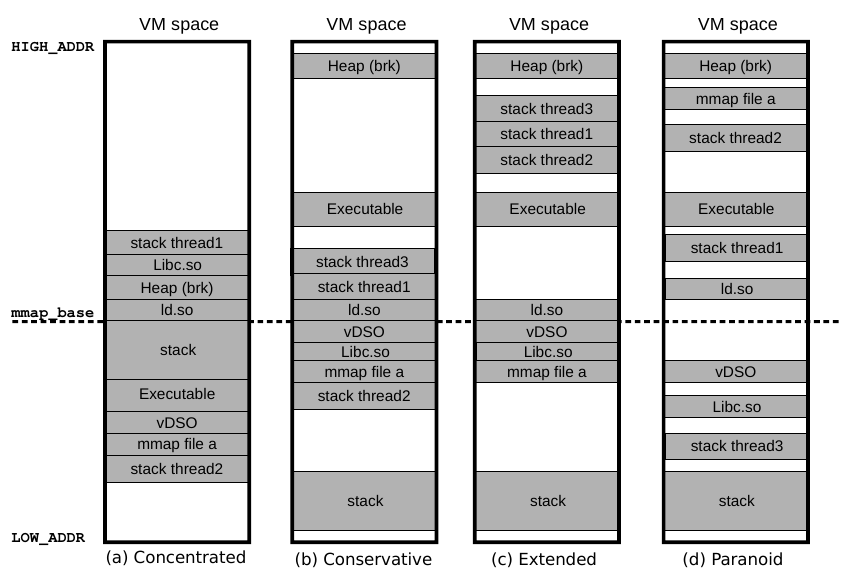
Figure 16. ASLR-NG: Profile mode